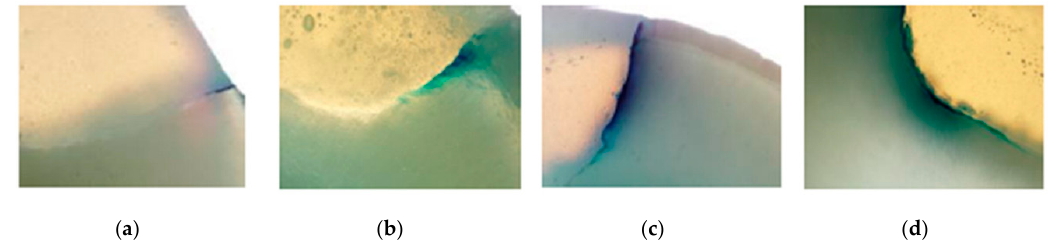
Figure 4. Samples of microleakage in ideal surface cavity conditions: ( a ) Dentsply “Prime and Bond Active”, ( b ) 3M ESPE “Single bond”, ( c ) Coltene “One Coat 7 Universal”, and ( d ) Kuraray “Clearfil Universal Bond Quick”.